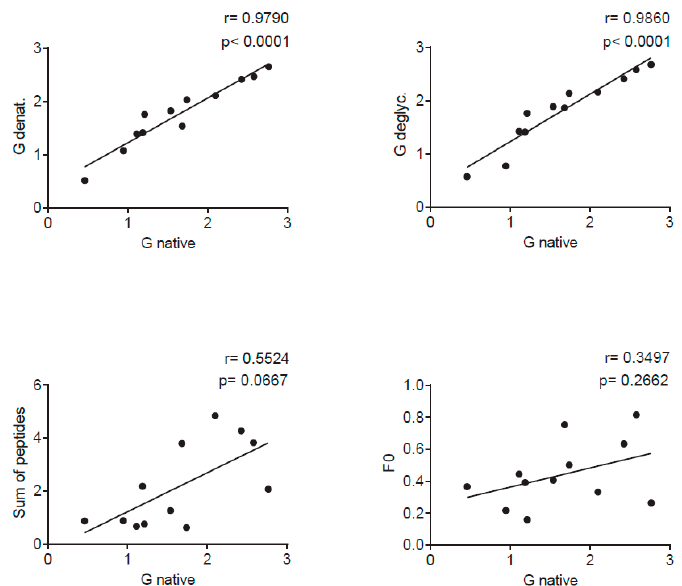
Figure 5. Correlations of IgG levels specific for native G (x-axes) and denatured G (SDS, TCEP and heat) ( y -axis) ( upper left ), deglycosylated G ( y -axis) ( upper right ), the sum of peptide-specific IgG ( y -axis) ( lower left ) and for F0 ( y -axis) ( lower right ) measured in sera from 12 adult individuals in individual scatter plots with Spearman correlation coefficient r and p values.